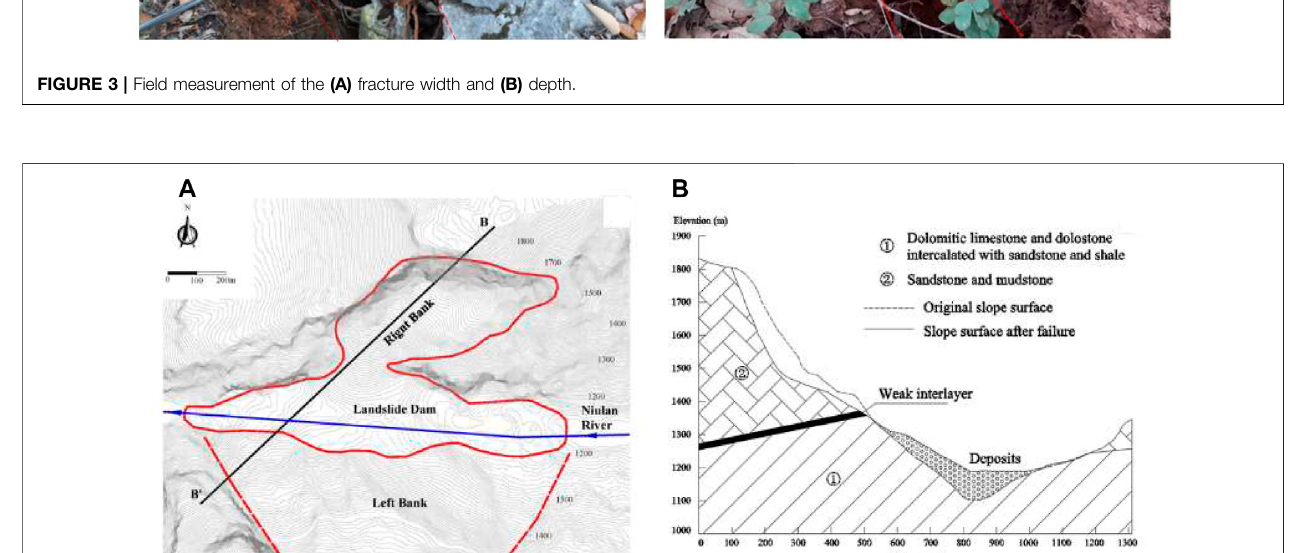
FIGURE 4 | (A) Engineering geological map of the Hongshiyan landslide; (B) cross-section along the main sliding